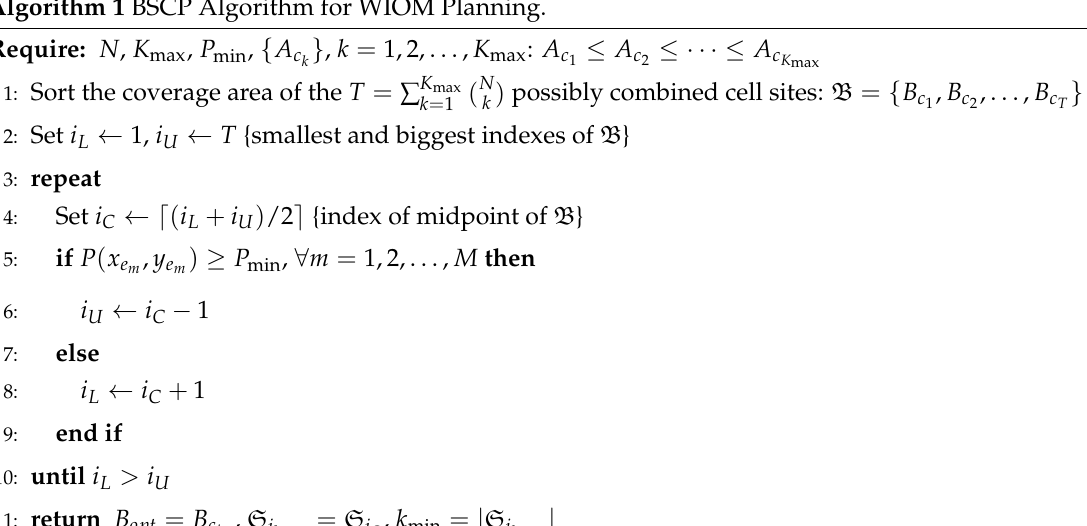
Algorithm 1 BSCP Algorithm for WIOM